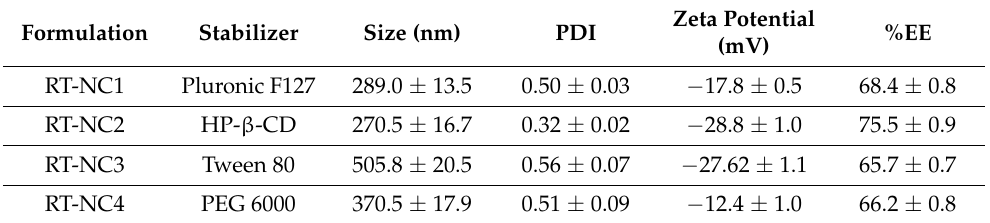
Table 2. Particle size, polydispersity index, zeta potential, and percent drug encapsulation efficiency of various RT-NCs formulations.